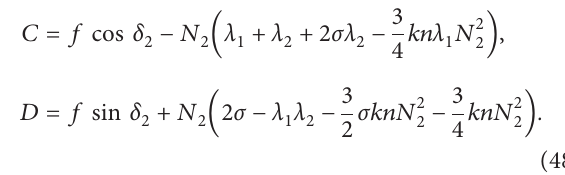
� 0 . 8 ; λ � 0 . 3 ; kn � 5 ; f � 1 2